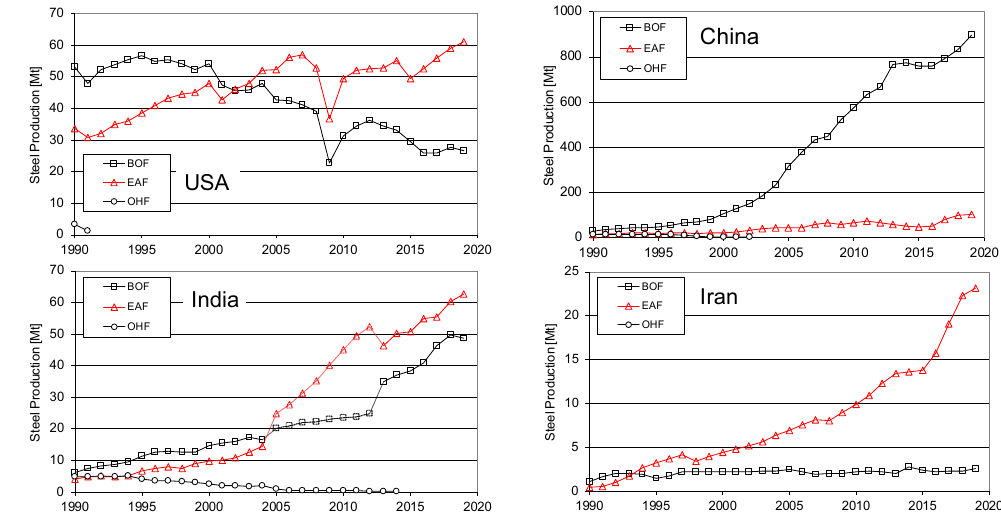
Figure 1. Four examples of electric arc furnace (EAF) steel production on different levels in the global steel industry (basic oxygen furnace, BOF; open hearth furnace, OHF); data from World Steel Association [1].